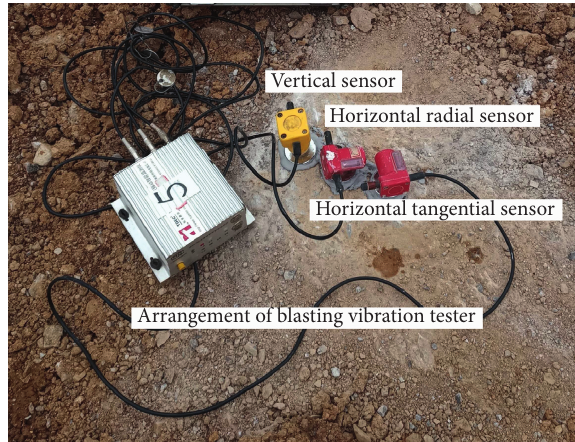
Figure 11: The arrangement of on-site blasting vibration